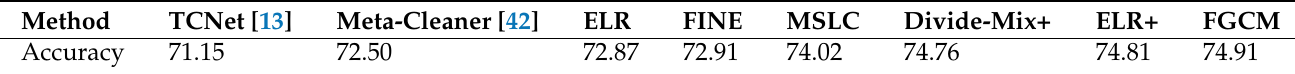
Table 4. Performance comparison with state-of-the-art methods on